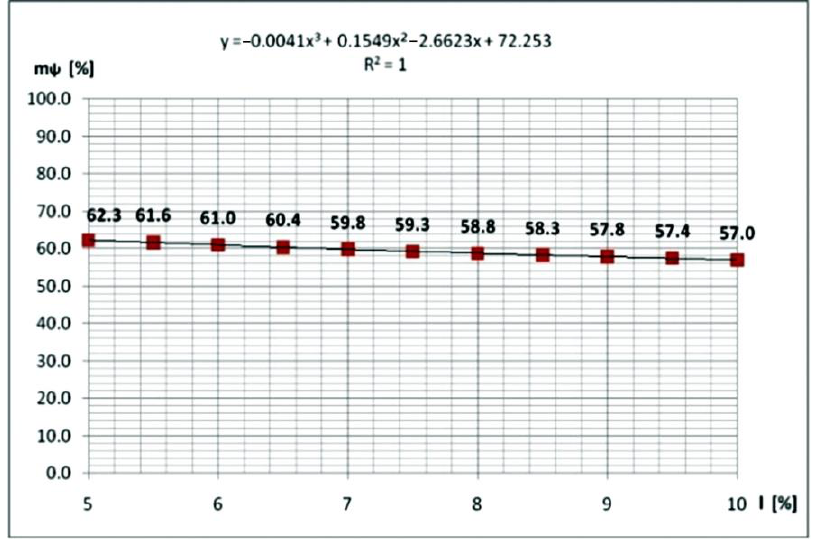
[%] along the second interval, ])......[( vs.